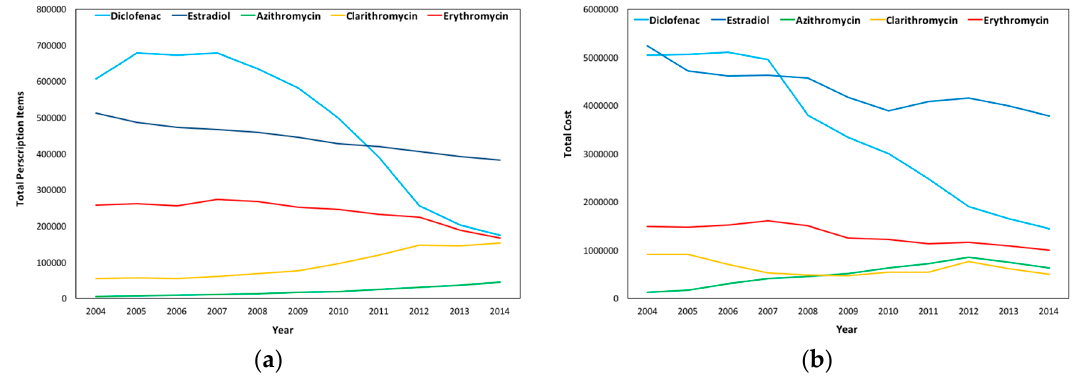
Figure 9. Wales’ Total ( a ) Prescription Items and ( b ) Cost (£) per substance from 2004 to 2014.